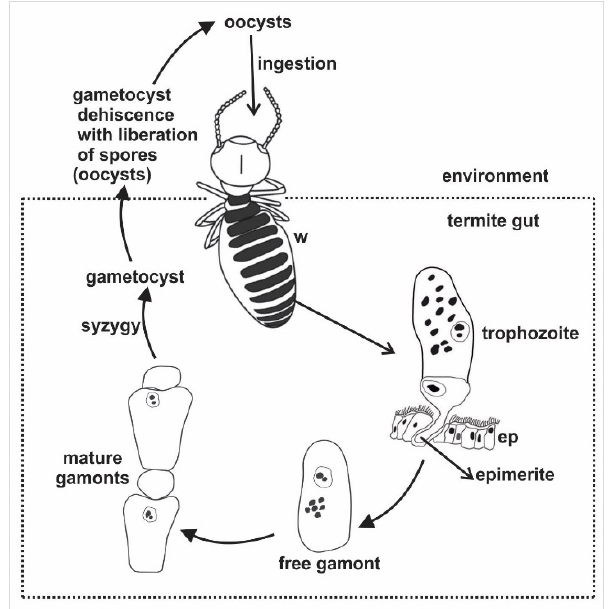
Fig 1 . Schematic representation of the gregarine life cycle which infect workers of Ruptitermes spp. Workers (w) ingest oocysts, containing sporozoites which develop into large stages named trophozoites. The trophozoites will attach to the gut epithelial cells (ep) through a special structure known as epimerite. After, the trophozoites will detach from the epithelium and form free gamonts. These free gamonts mature and undergo syzygy, originating the gametocyst that will be released into the